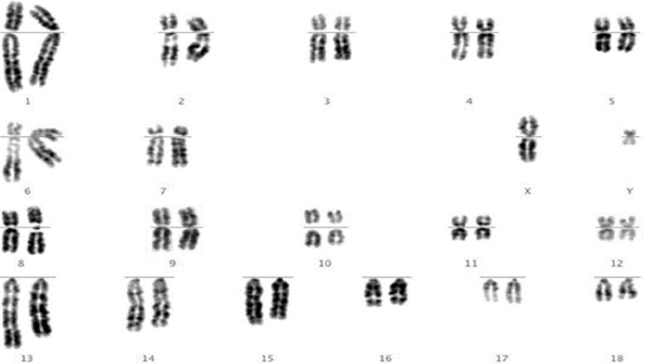
Figure 2. Chromosomes of a boar identified as carrying a reciprocal translocation of chromosomes 2 and 14. The longer chromosome 2 and shorter chromosome 14 are clearly visible.